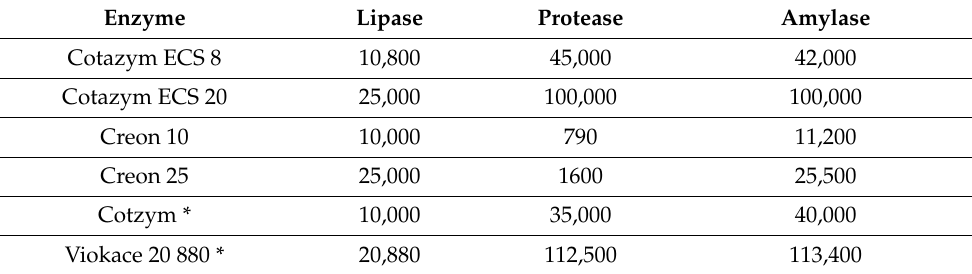
Table 2. Breakdown of pancreatic enzyme replacement therapy